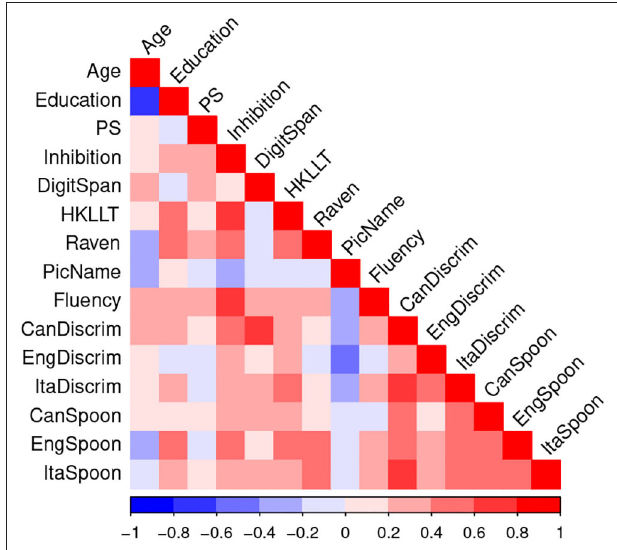
FIGURE 6 | Correlation matrix among demographic, cognitive, and phonological measures at the initial-learning phase.